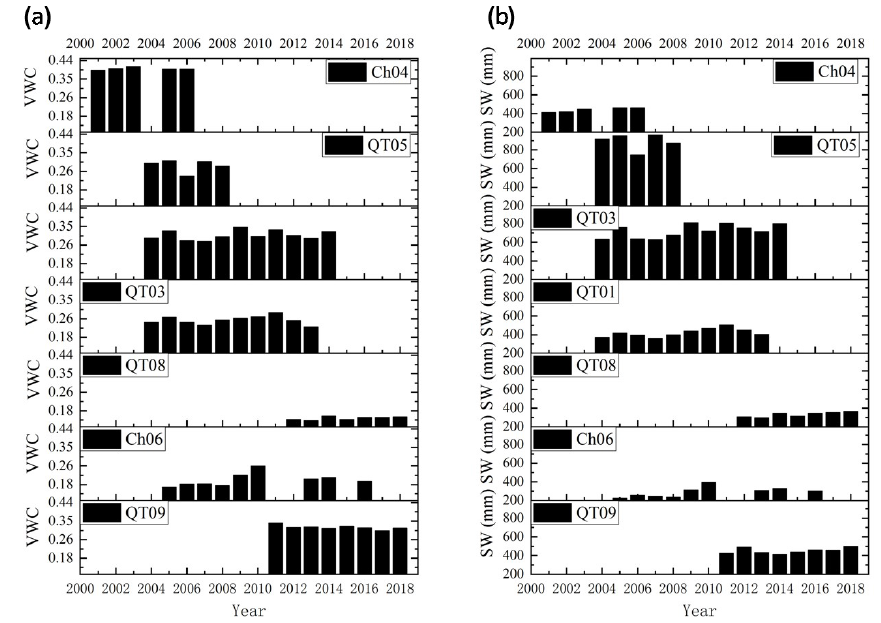
Figure 9. Variation in volumetric water content and soil water equivalent among different sites.